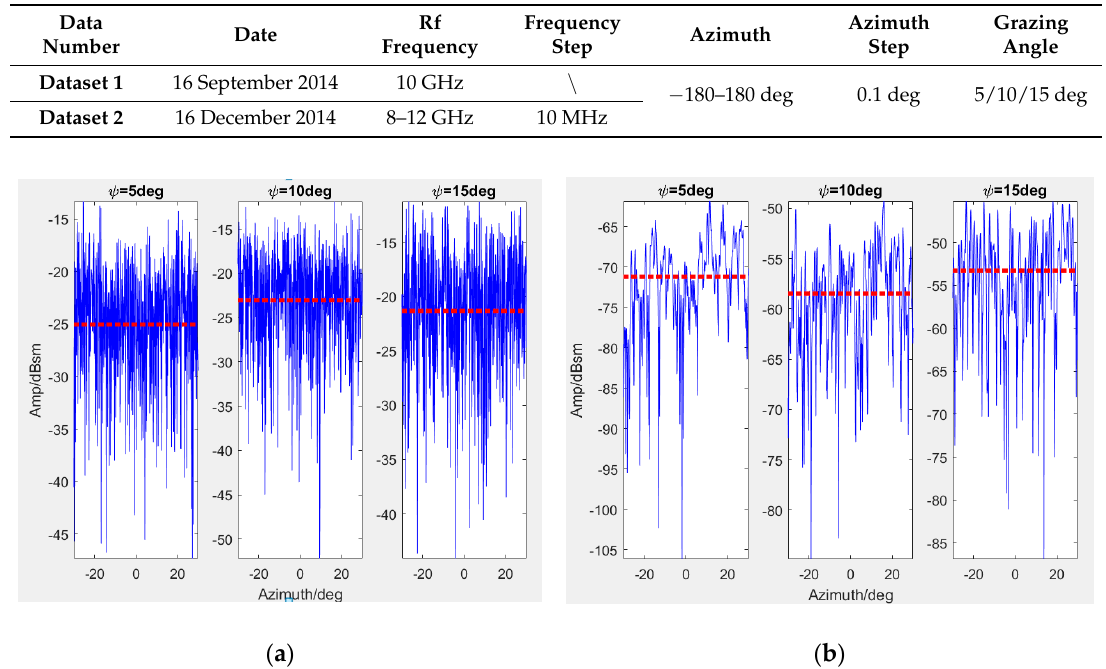
Figure 7. Measured data and the statistical average values about the backscattering coefficients from Science and Technology on Electromagnetic Scattering Laboratory ( a ) Dataset 1 ( b ) Dataset 2 ( = 10 GHz).